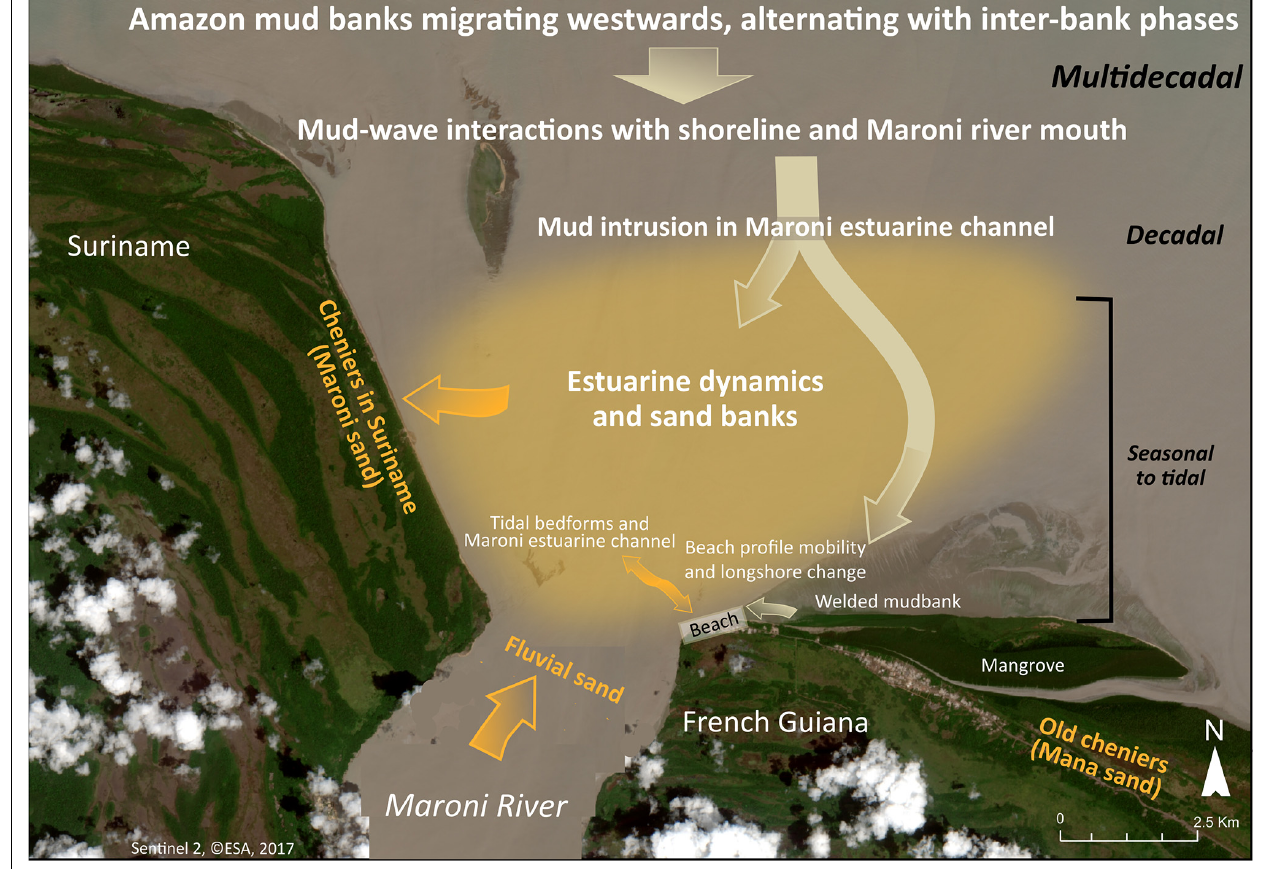
FIGURE 12 | Conceptual model of multi-decadal to short-term changes at Yalimapo beach, French Guiana. The morphology and dynamics of the beach are influenced, at embedded spatial (regional to local) and temporal (multi-decadal to daily) timescales, by the relationship and interactions among various sediment bodies and forces. These are the regional mud banks migrating under wave and wind influence at > decadal to multi-decadal timescales westward from the Amazon to the Orinoco, wave dissipation by these banks and by the large estuarine sand bank infilling the mouth of the Maroni River, and at a timescale of several years, mud intrusion into the mouth of the Maroni and local welding of mud released by the banks onto the beach. Seasonal modulation of wave activity, the local influence of the main Maroni estuarine channel, strong tidal currents on the inner shoreface adjacent to the beach, and sand exchanges, at fortnightly tidal to semi-daily scales between beach and inner-shoreface tidal bedforms, are reflected in beach profile and alongshore mobility at the local